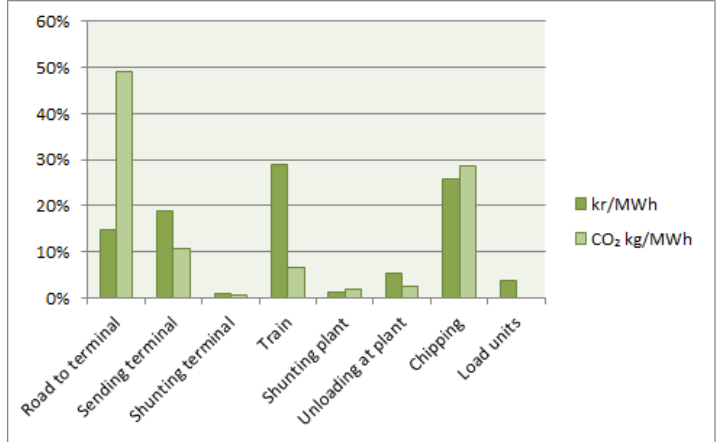
Figure 6. Costs and emissions in the base